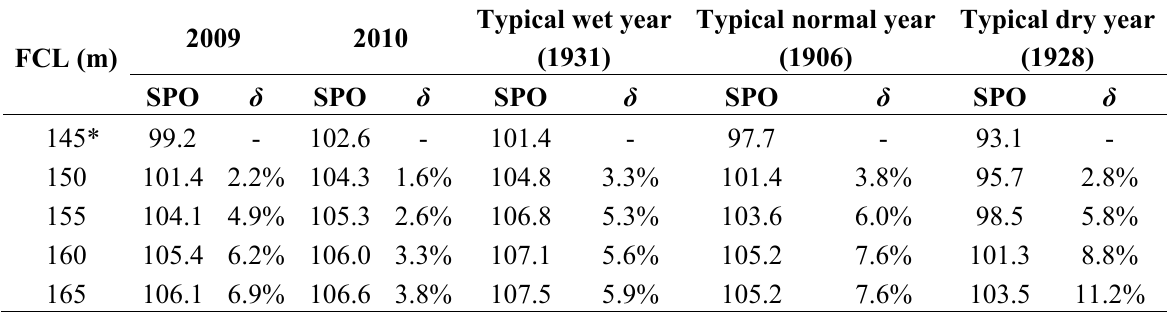
Table 5. Impact of increasing flood control level on power output of Three Gorges and Gezhouba cascade complex for different hydrological years